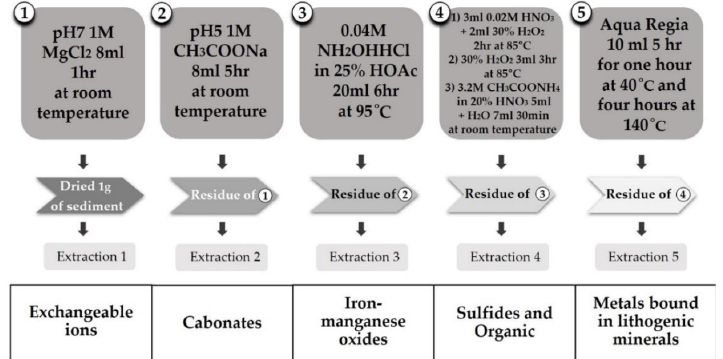
Figure 2. Tessier’s five-step extraction flow chart.